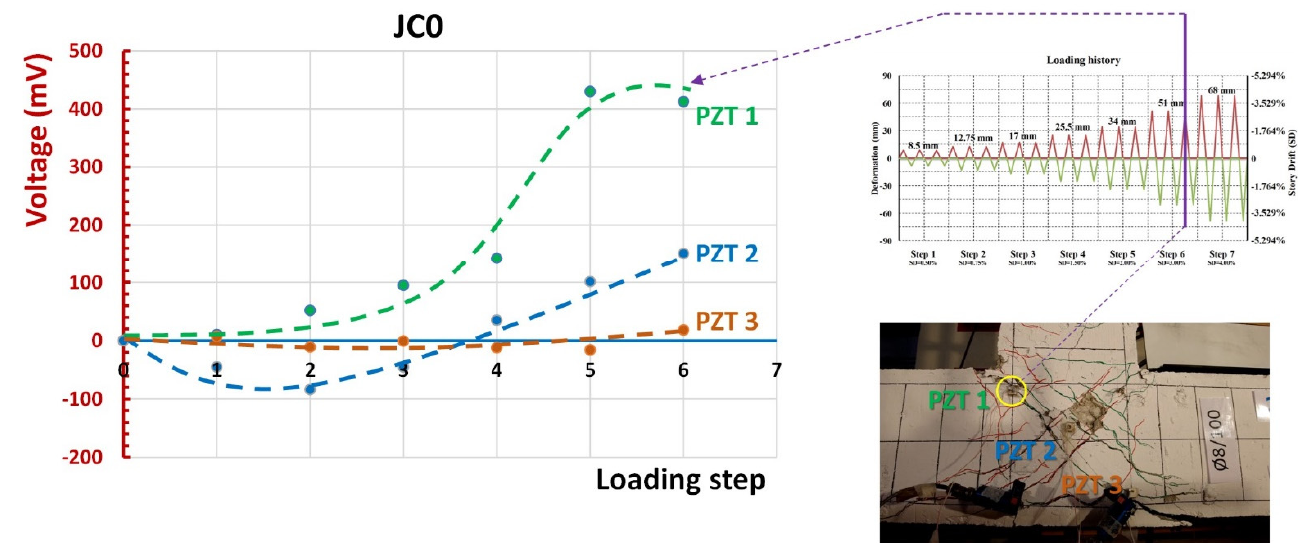
Figure 14. Voltage differences between the peak voltage value recorded at each loading step minus the voltage at the same frequency in the healthy condition, representing the level of the damage that occurred in the vicinity of the PZT patch. PZT 1 transducer at the 5th and 6th steps of the loading procedure exhibited substantial increase in the voltage output indicating significant change/damage, as can be verified in the photograph of the cracking pattern of specimen JC0 after the imposed loading sequence.